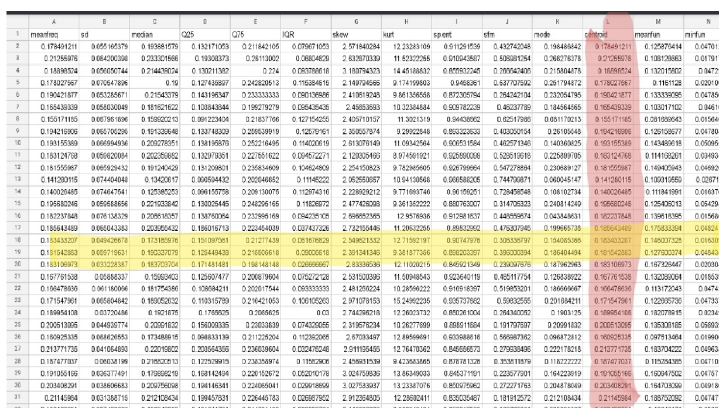
Figure 2. Sample Excel multidimensional